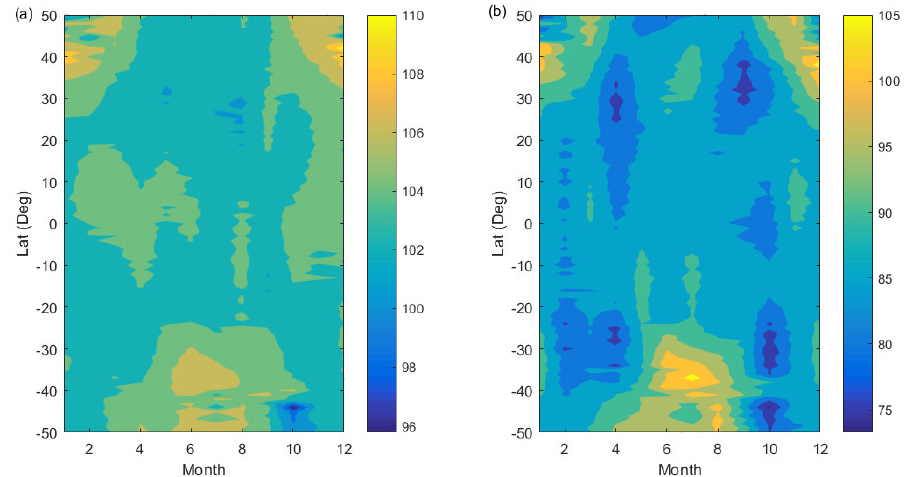
Figure 4. Month–Latitude Variations in the ( a ) higher boundary and ( b ) lower boundary of the “wave turbopause” layer by line fit averaged from 2004 to 2013.